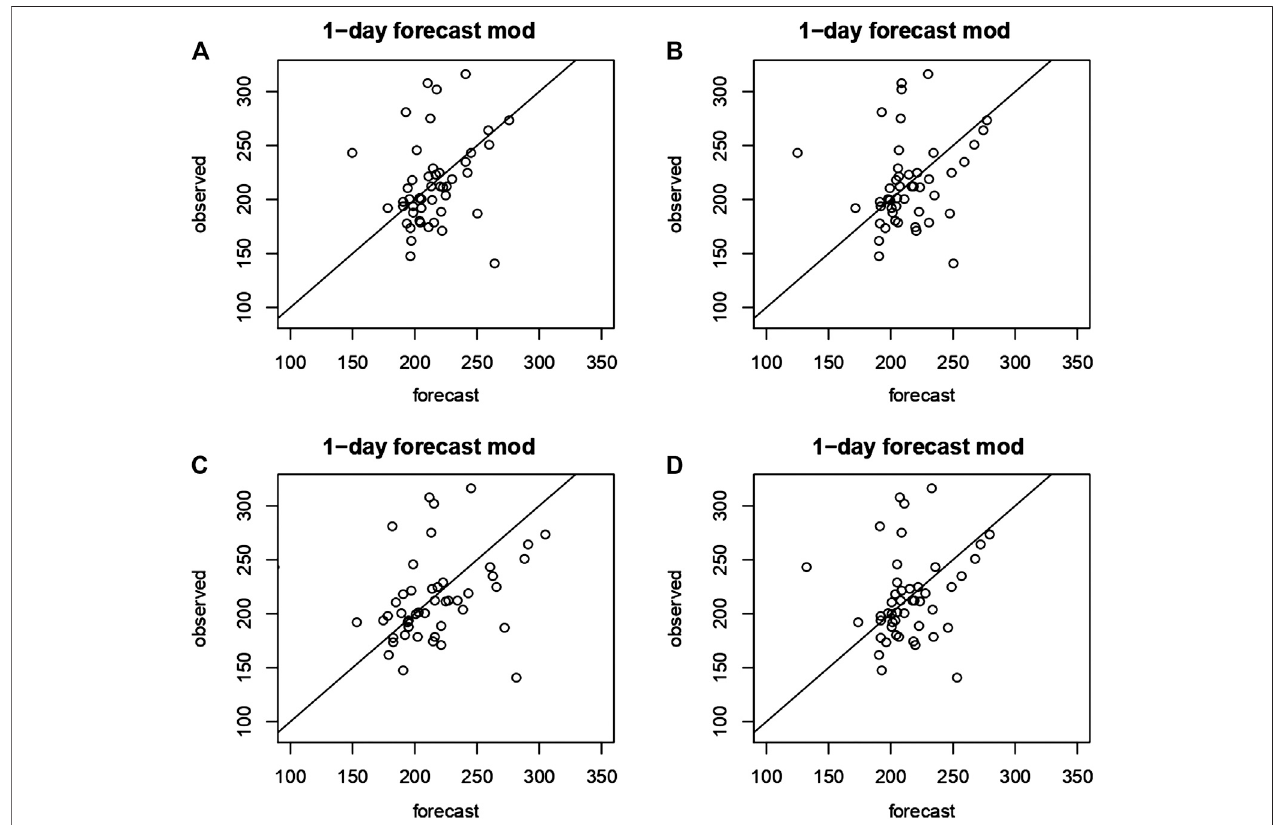
FIGURE 7 | Prediction at 1-lag and observed radon measurements for the estimated Models (A – D) as labeled in Table 1 .